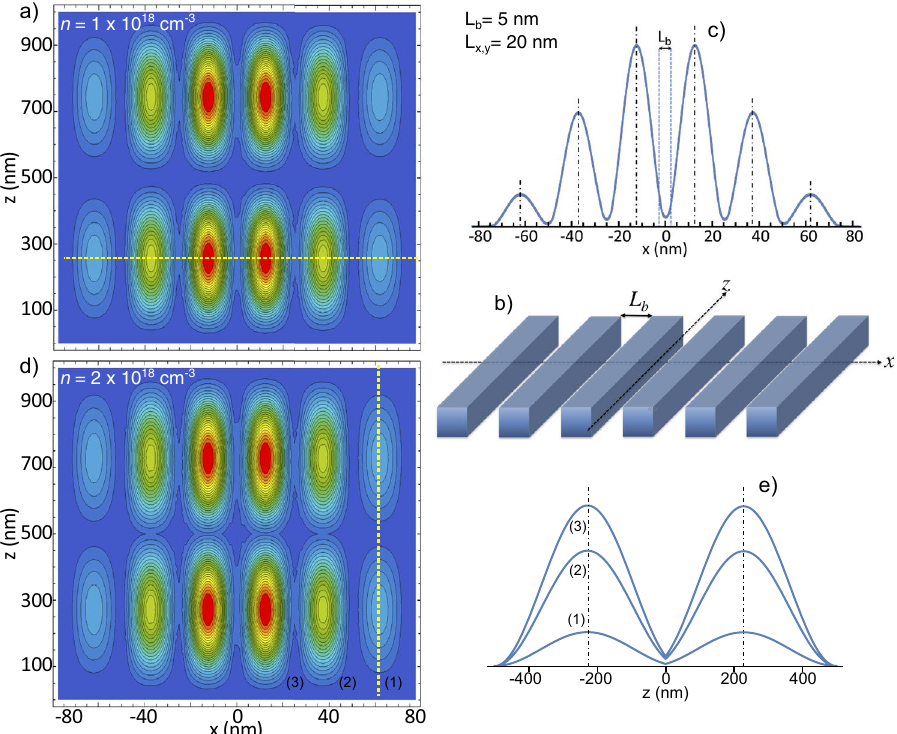
Figure 4. ( a ) Ground state charge distribution for an array of six 1-micron long PNWs of cross section 1 10 18 electrons/cm 3 , and mutual separation L 20 nm, n 5 nm. ( b ) Illustrative representation of L x , y b = = × = 6 GaAs/AlGaAs PNWs array. ( c ) Profile of the electronic density taken along the horizontal yellow line the 1 × 10 18 electrons/cm 3 in order to trigger the connection between the indicated in ( a ). In ( d ), n is increased to 2 × charge distributions along the z -axis. In ( e ), three profiles taken along the z direction from ( d ) are plotted; the vertical yellow line in ( d ) indicates where the profile number (1) was